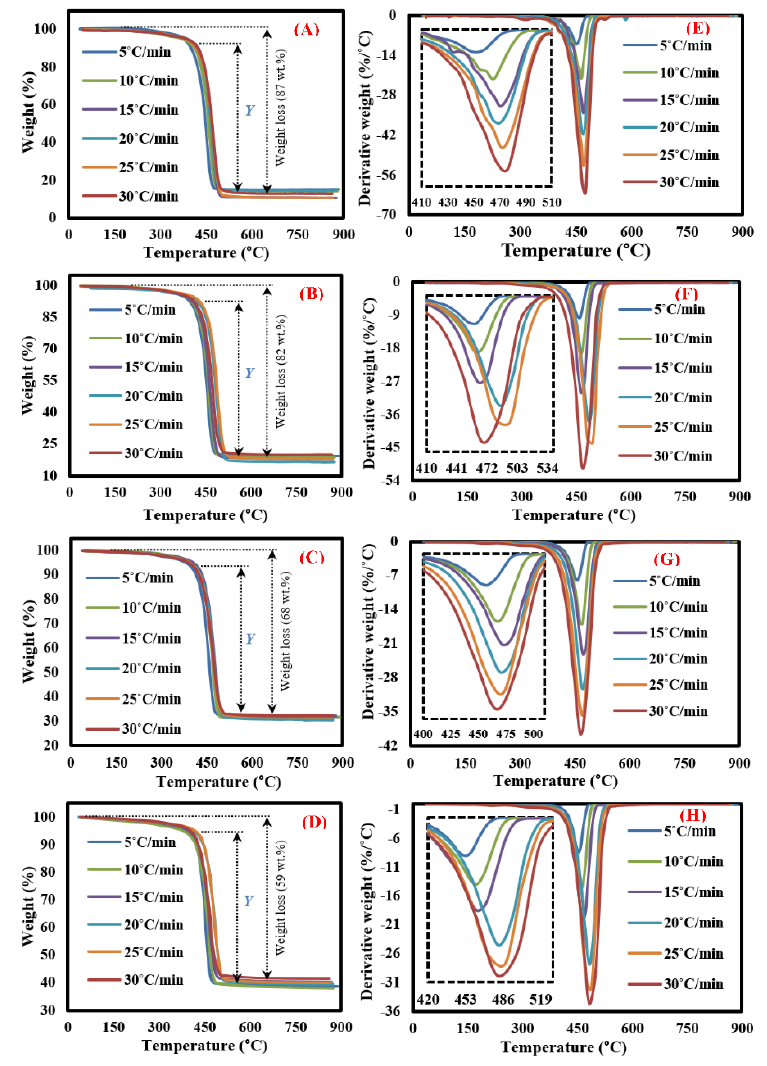
Figure 2. ( A – D ) TGA analysis and ( E – H ) DTG analysis of metallized food packaging plastics waste (MFPW) loaded with 0, 10, 30, and 50 wt.% at different heating rates.